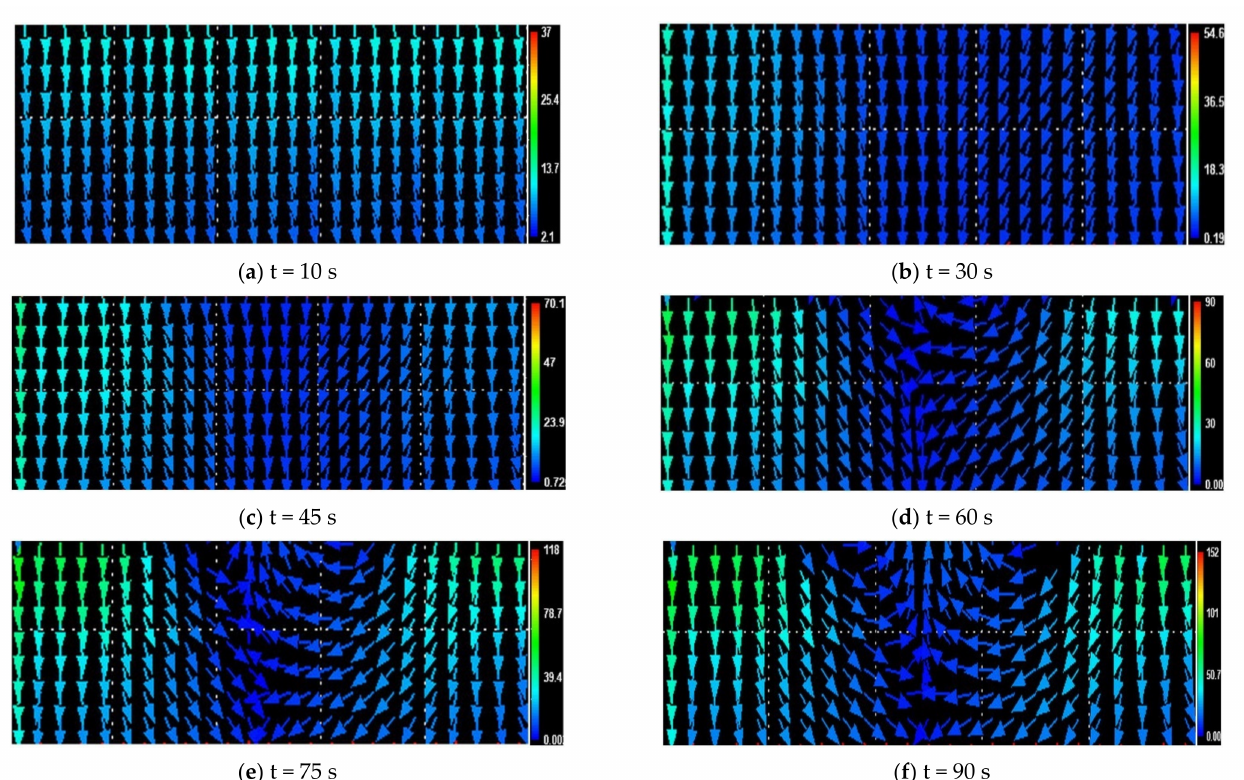
Figure 4. Vector graphs at different